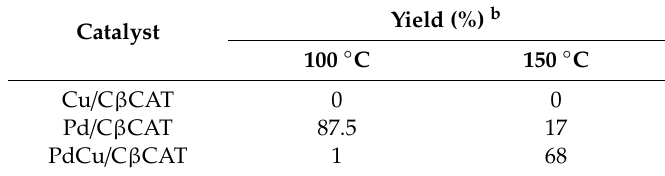
Table 3. MW assisted Nitroarene reduction tests in the presence of C β CATs a .